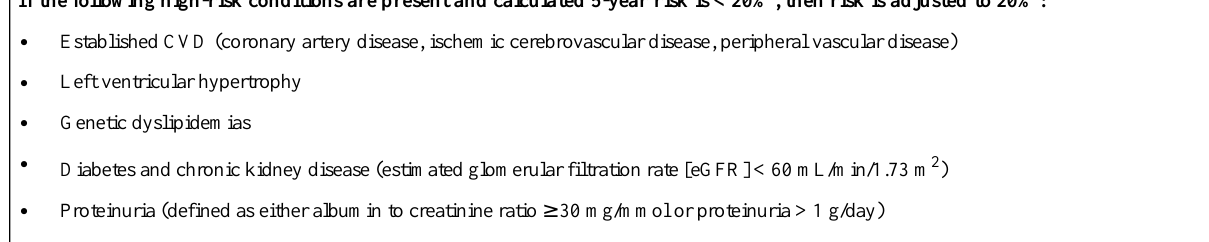
a single algorithm [26,28-31]. The thresholds and treatment targets for BP, lipid, and anti-platelet management are summarized in Textbox